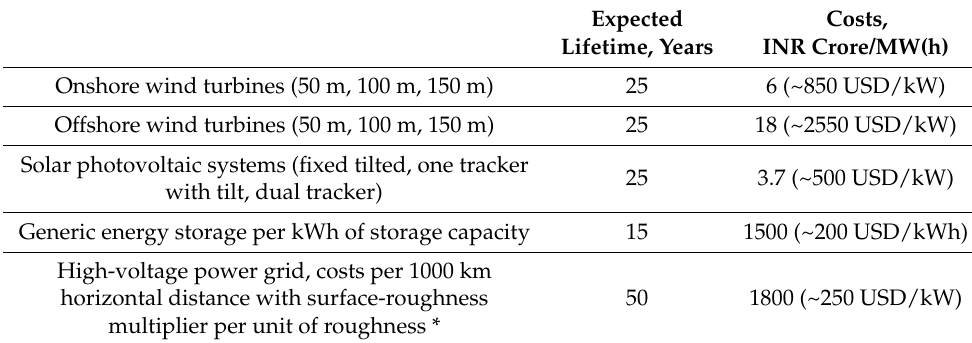
Table 1. Investment cost assumptions by technology.